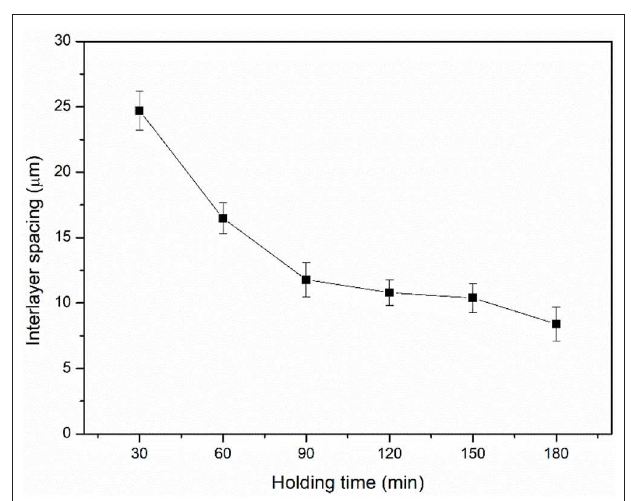
FIGURE 3 | Variation tendency of interlayer spacing sintered with different holding times.